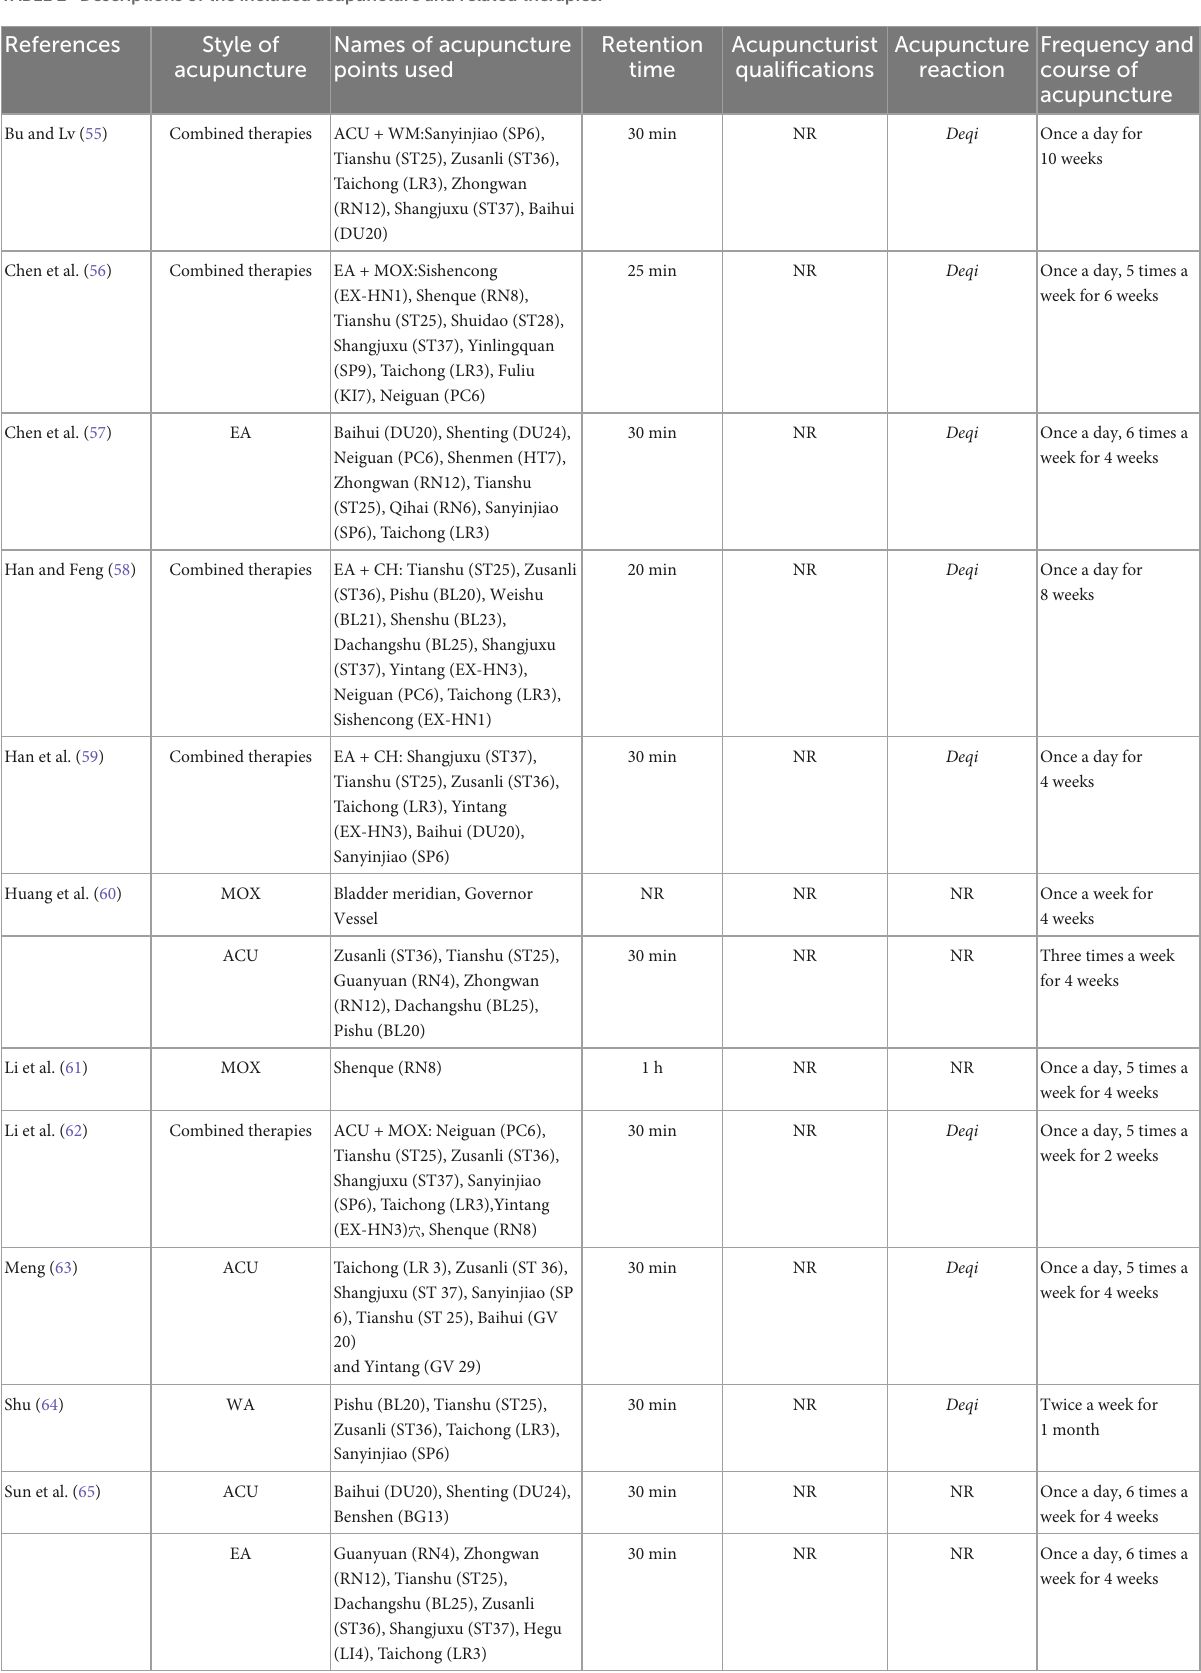
TABLE 2 Descriptions of the included acupuncture and related